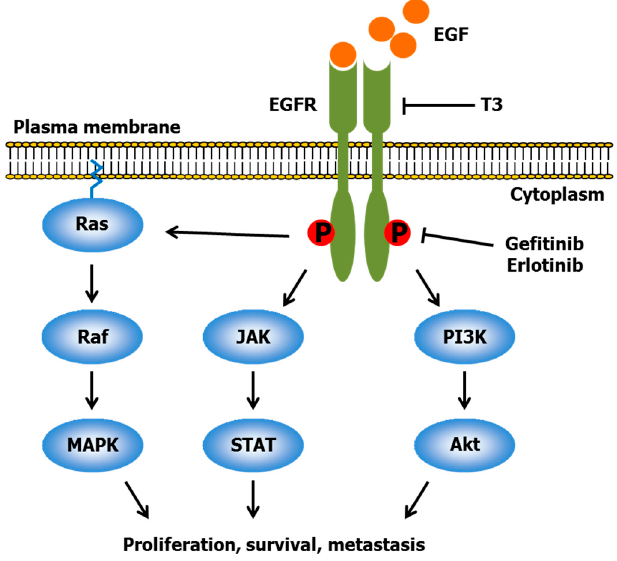
Figure 3. Epidermal growth factor receptor (EGFR) and its downstream signaling proteins. EGF, epidermal growth factor; EGFR, epidermal growth factor receptor; JAK, Janus kinase; STAT, signal transducer and activator of transcription; PI3K, phosphatidylinositol 3-kinase; MAPK, mitogen-activated protein kinase; Akt, protein kinase B; P, phosphorylation. Arrows and perpendicular lines indicate activation/induction and inhibition/suppression, respectively.